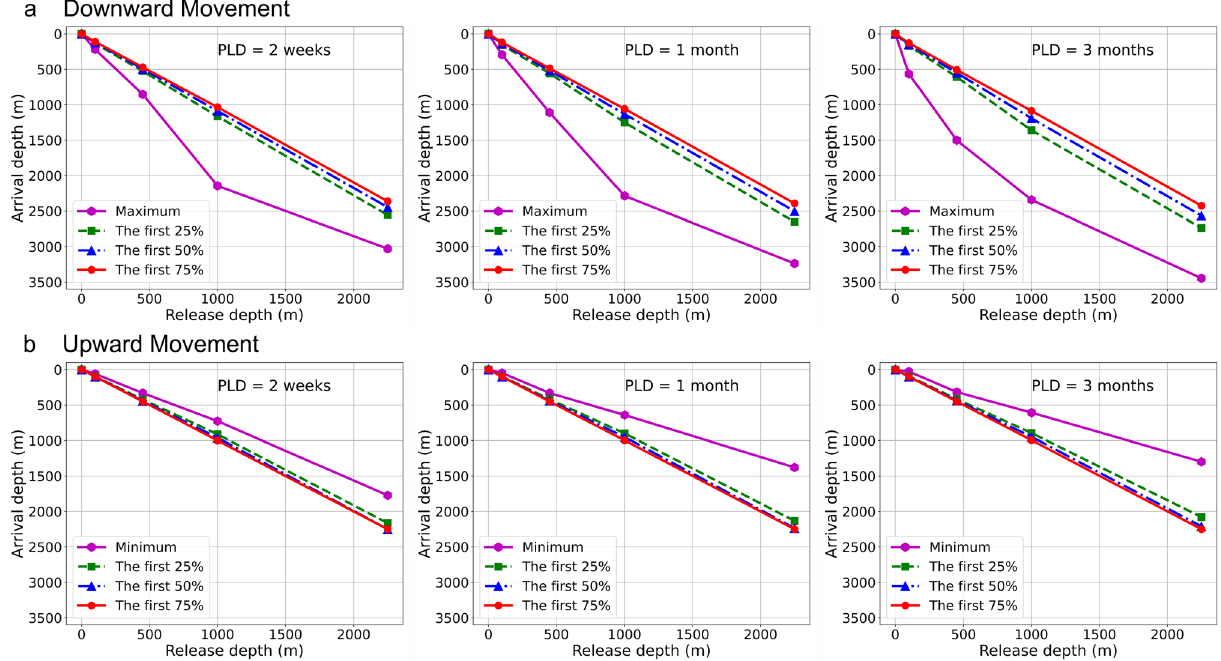
Figure 2. Vertical Particle Movements. ( a ) downward and ( b ) upward minimum depths that forward-tracked particles reached under each of 3 pelagic larval drift durations (PLD) using 3-D models and the average current for 5 particle release depths (surface, 100 m, 450 m, 1000 m and 2250 m). The depths for which the arrival of the first 25% (green lines and symbols), 50% (blue lines and symbols) and 75% (red lines and symbols) of particles are shown for each